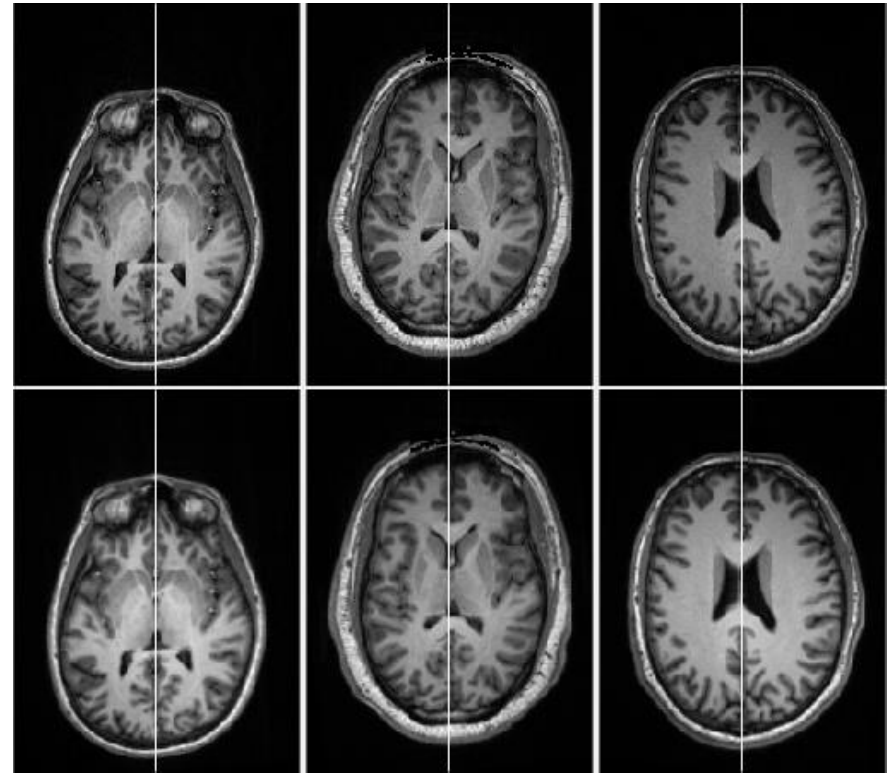
Figure 15. The results of symmetric detection and tilt correction (realignment of the brain head volume). The input head volumes images are in the first row and reoriented (recentered) head volumes images are in the second row.